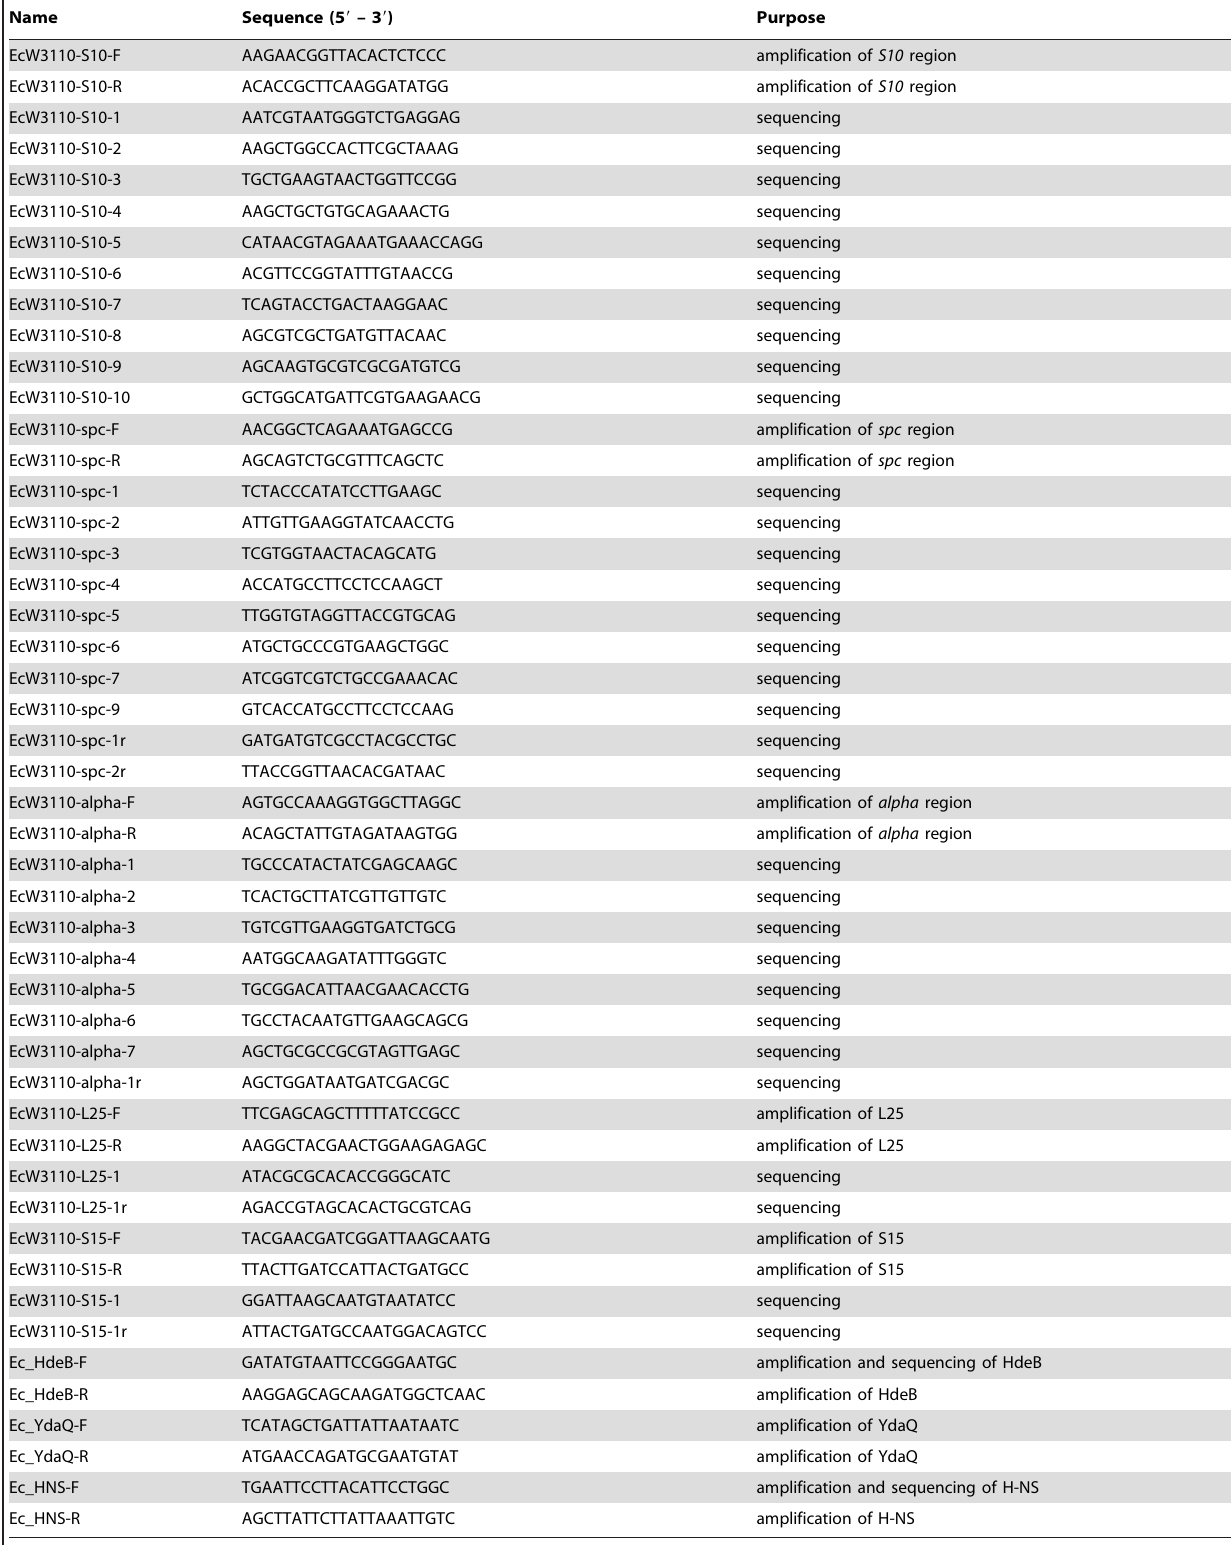
Table 2. Primers used in this